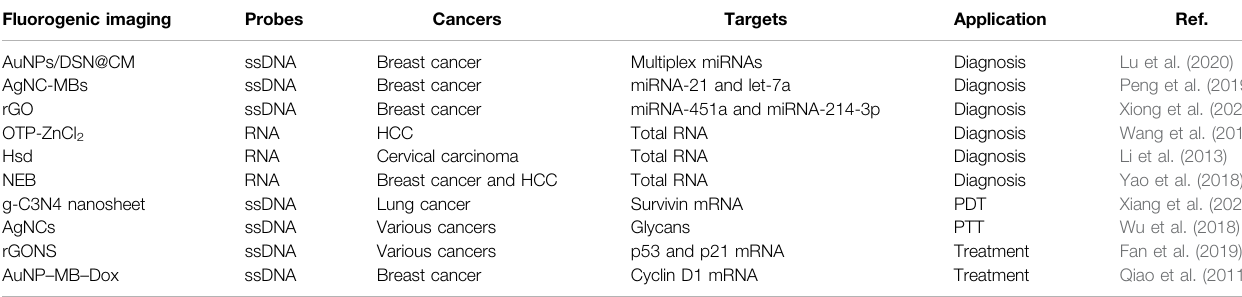
TABLE 2 | Application of nucleic acid probe – based fl uorescent imaging in cancer diagnosis and